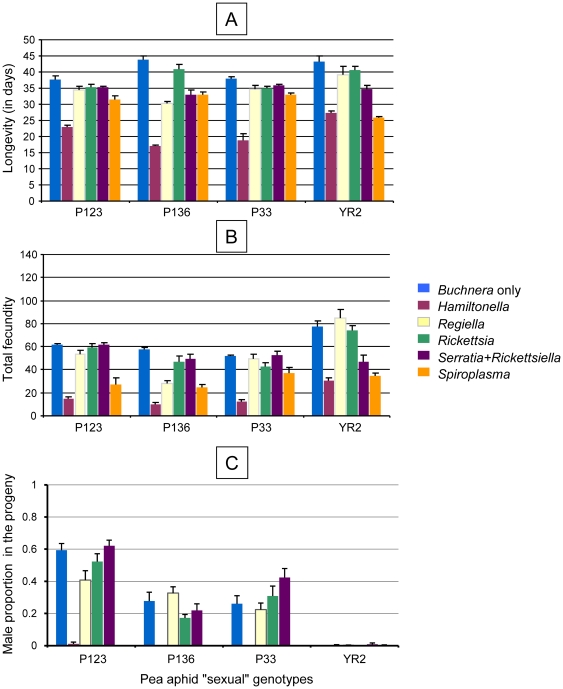
Influence of symbiont component on history traits of artificially infected lines of four “sexual” genotypes of the pea aphid exposed to standard conditions of sex induction (experiment 1).A) longevity, B) fecundity and C) sex ratio (given as the proportion of females in the sexual fraction of the progeny).